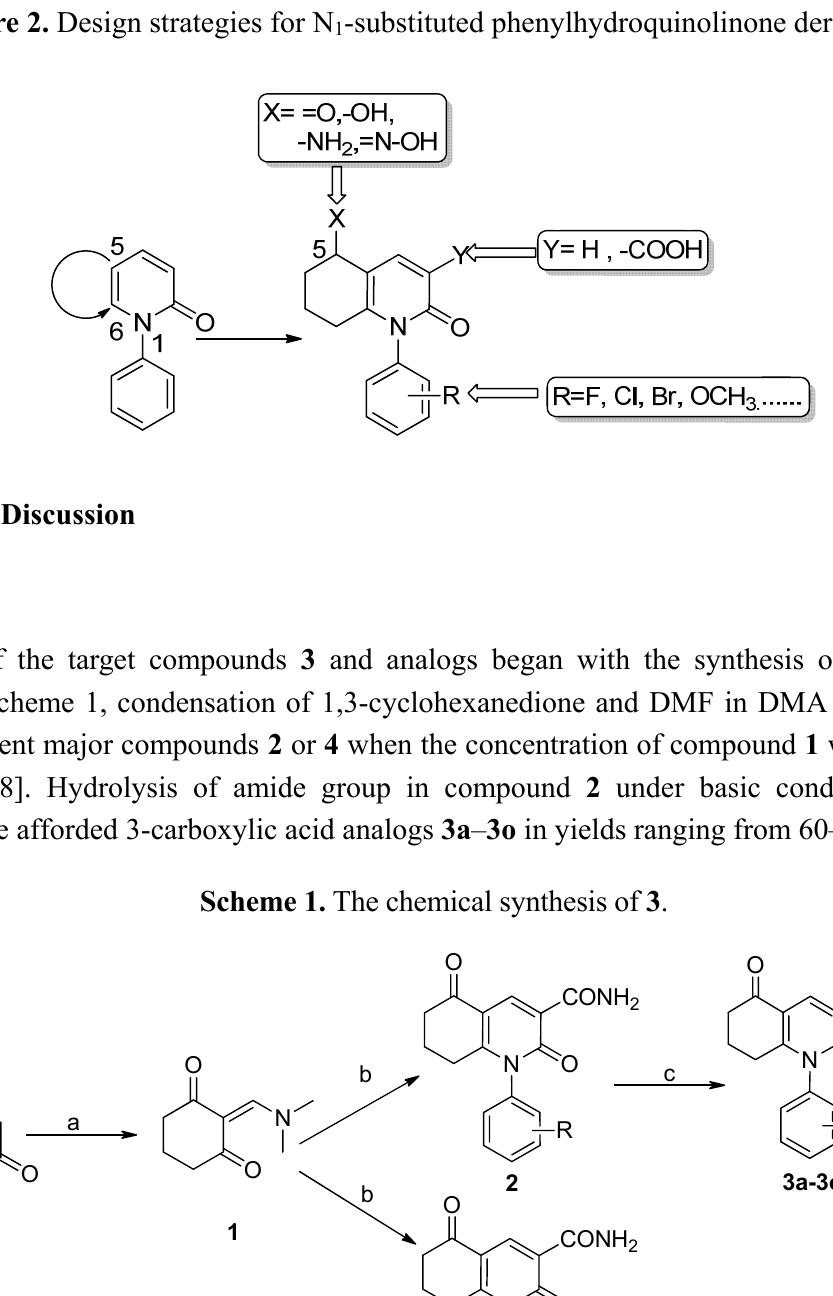
Figure 2. Design strategies for N